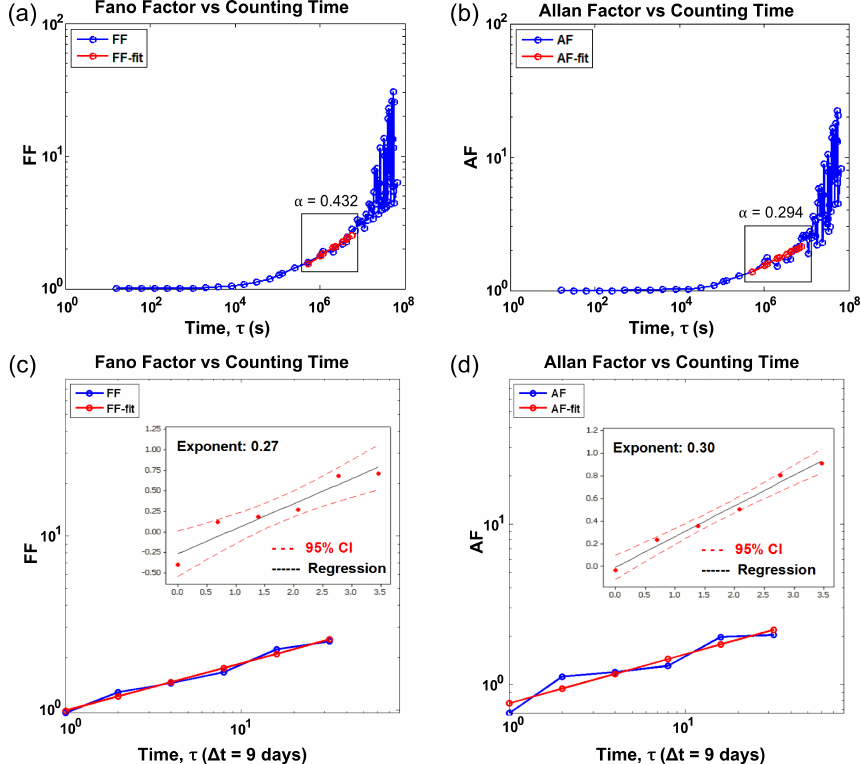
Figure 6. (a, b) The Fano and Allan factor graphs, respectively, derived from the earthquake catalogue data using the approach of Telesca et al. (2001, 2009, 2011) and Telesca and Lovallo (2008); (c, d) the Fano and Allan factor graphs, respectively, for the time series of the state-to-state transition frequencies of the modified Markov chain model of the earthquake